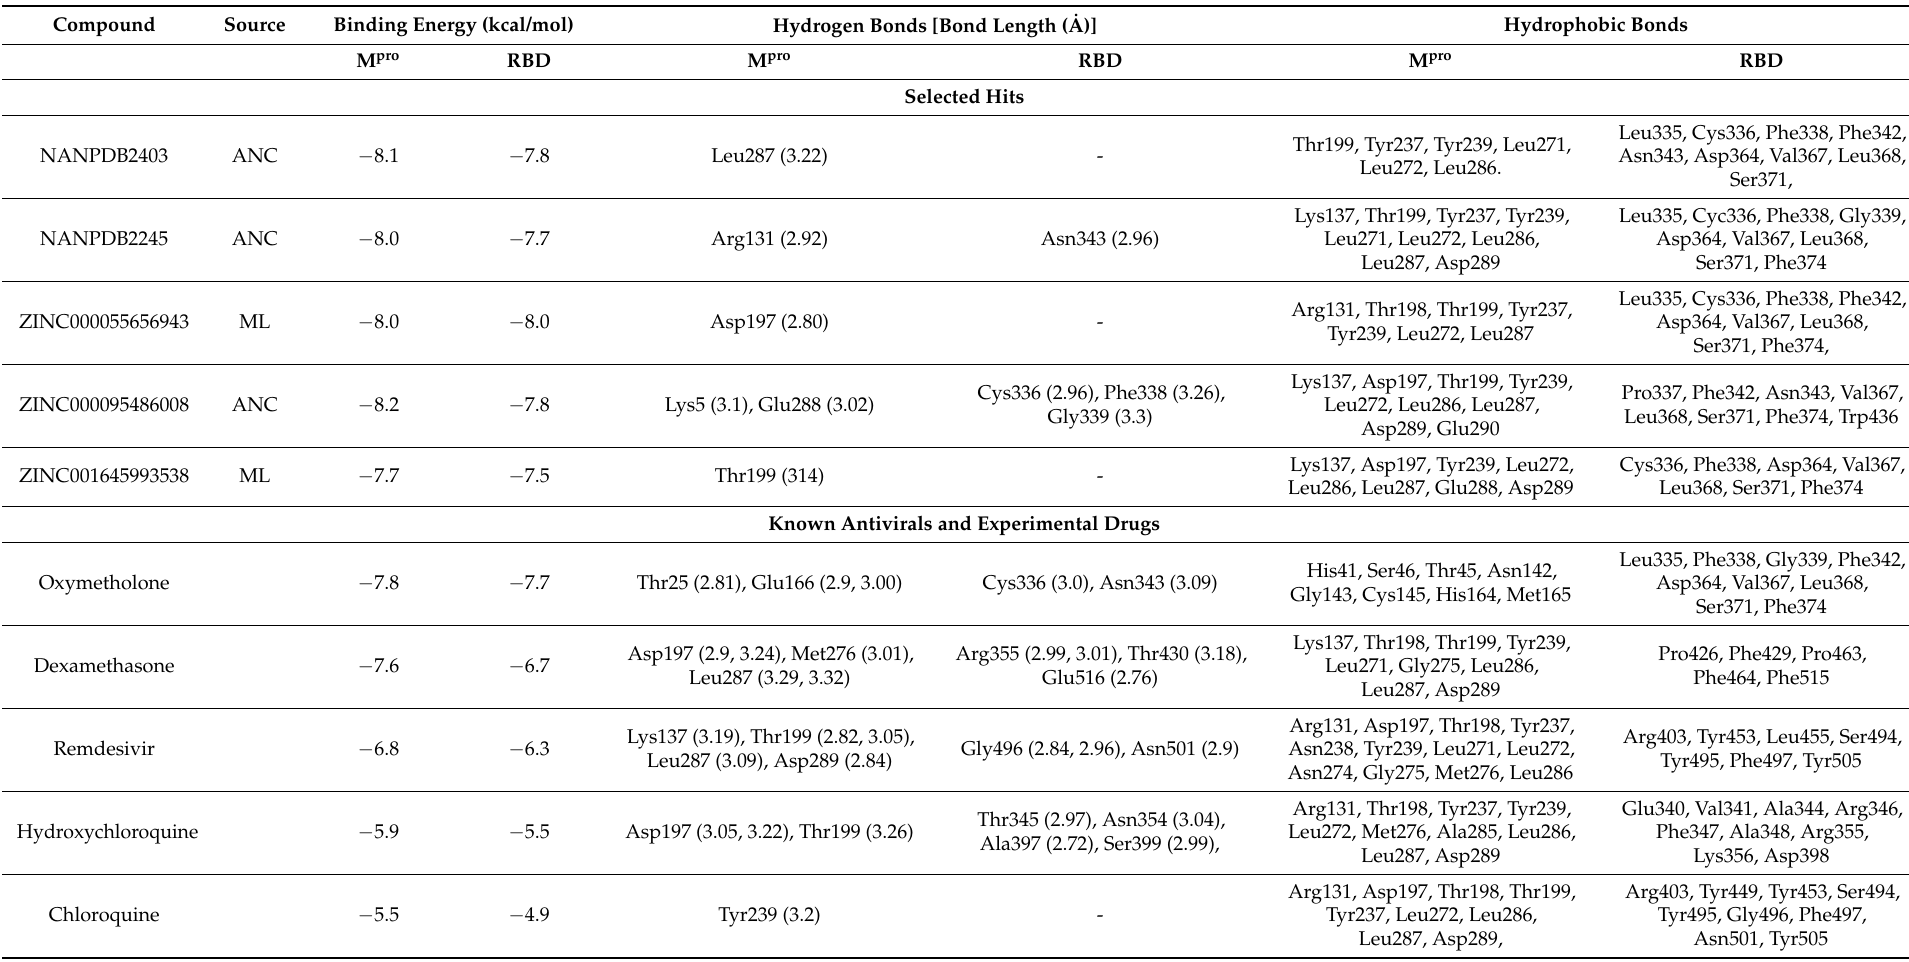
Table 2. The binding energies and intermolecular interactions between selected compounds and M pro as well as RBD. Compounds are from the African Natural Compounds (ANC) database and Machine Learning Study (ML). In addition, antivirals and experimental drugs are